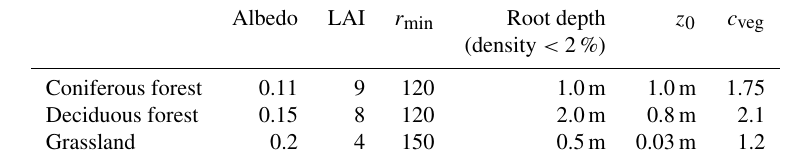
Table 2. Vegetation parameters of the different land use classes in summer.